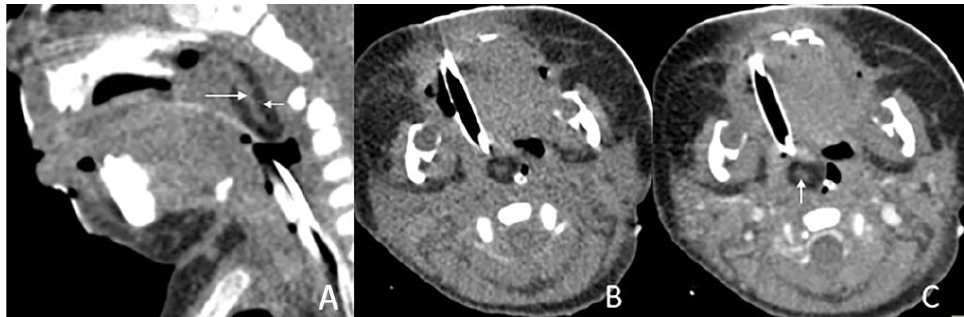
Figure 2. CT of a 1-month and 16-day girl presenting with throat congestion 29 days after birth. ( A , B ) Sagittal and axial CT, displayed in the soft-tissue window, shows a sausage-like fat density mass (short arrow) with a soft tissue density core (long arrow) originating from the left lateral pharyngeal wall. ( C ) Axial, postcontrast CT, displayed in the soft-tissue window, shows that the lesion’s stalk is slightly enhanced (arrow), but the rest of the lesion is not enhanced.